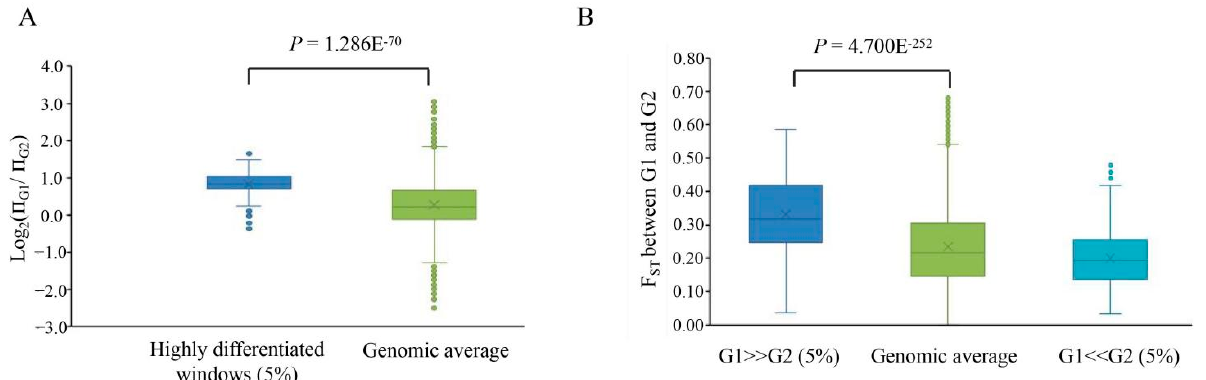
Figure 10. Relationship between relative genetic diversity (G1/G2) and the genetic differentiation index between the G1 and G2 subpopulations. ( A ) Comparison of relative genetic diversity and population mean of G1-G2 high differentiation window; ( B ) relative genetic polymorphism ( Π G1/ Π G2) comparison of genetic differentiation index and population mean of maximum and minimum 5% windows. The p -value was based on independent t -test. G1: G1 subpopulations of DXWR, G2: G2 subpopulations of DXWR.